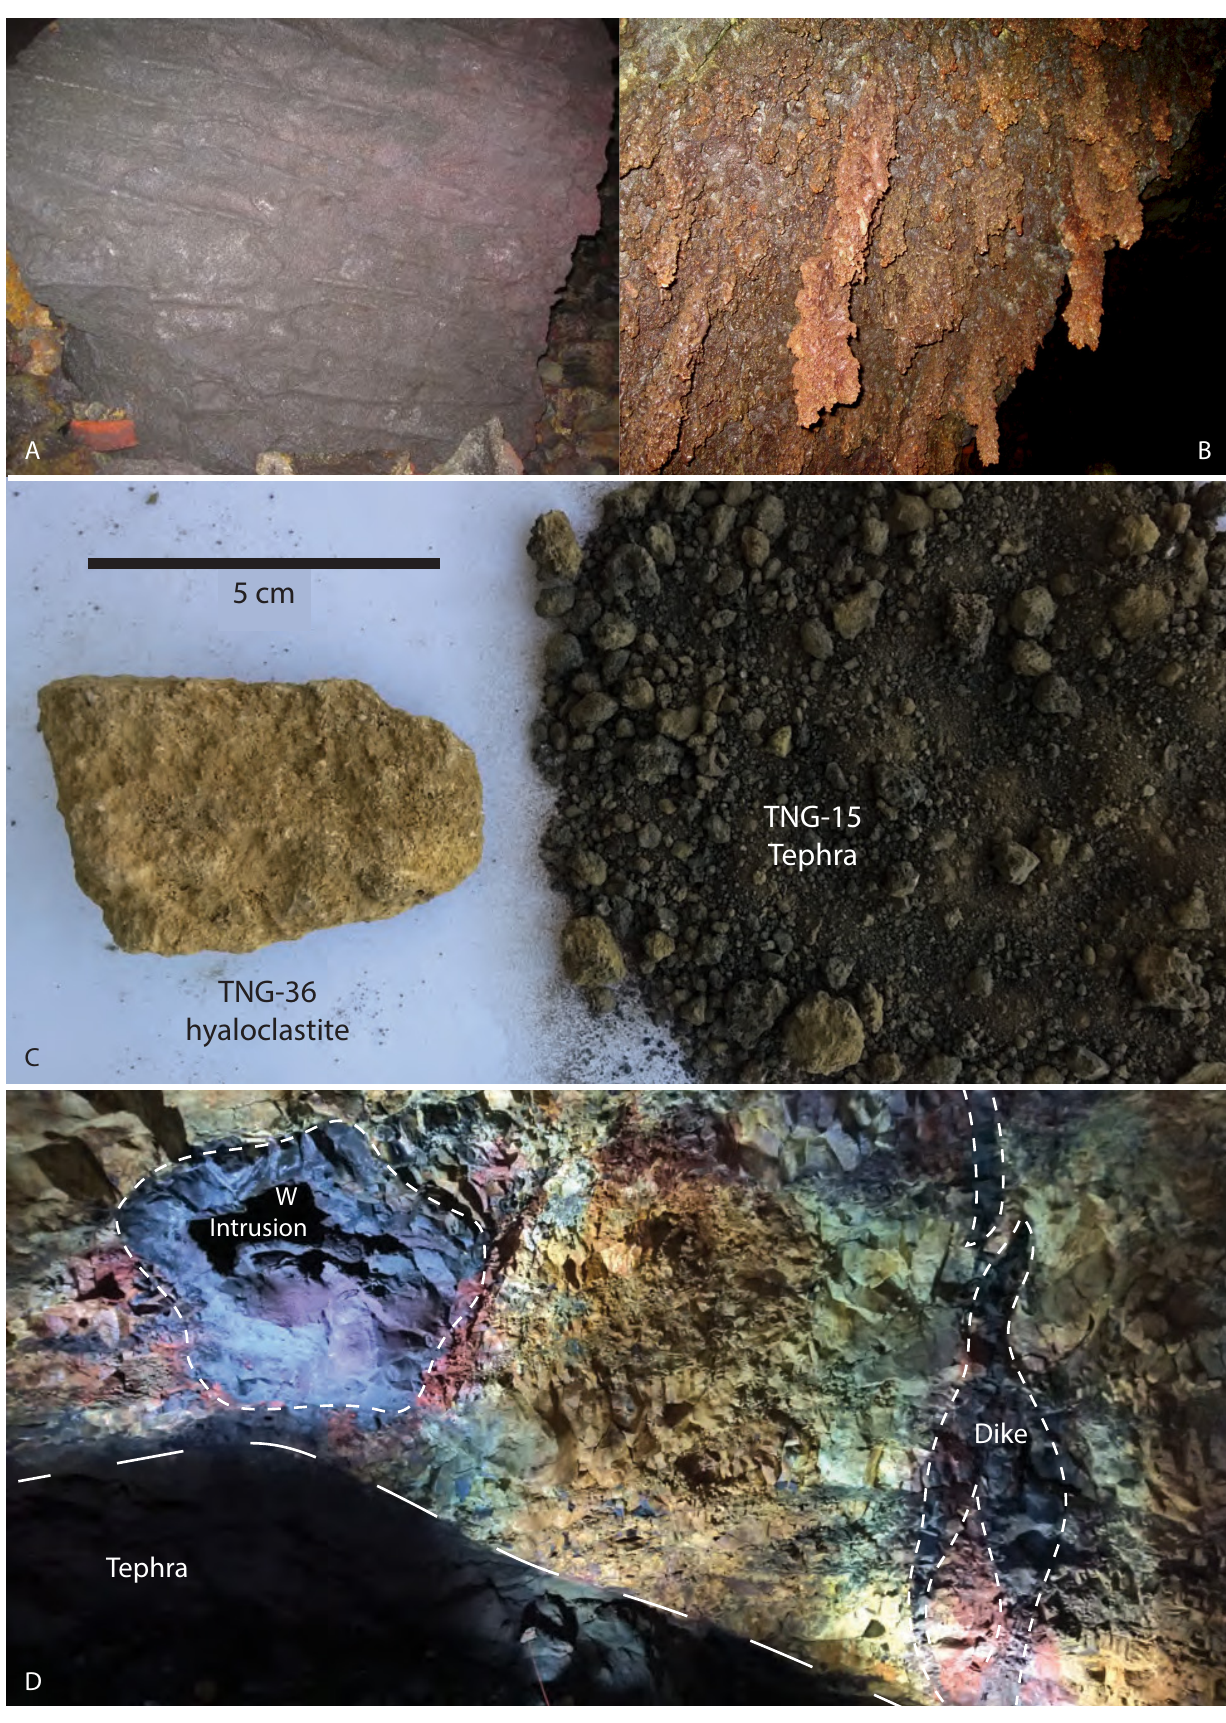
Figure 5: (Caption next